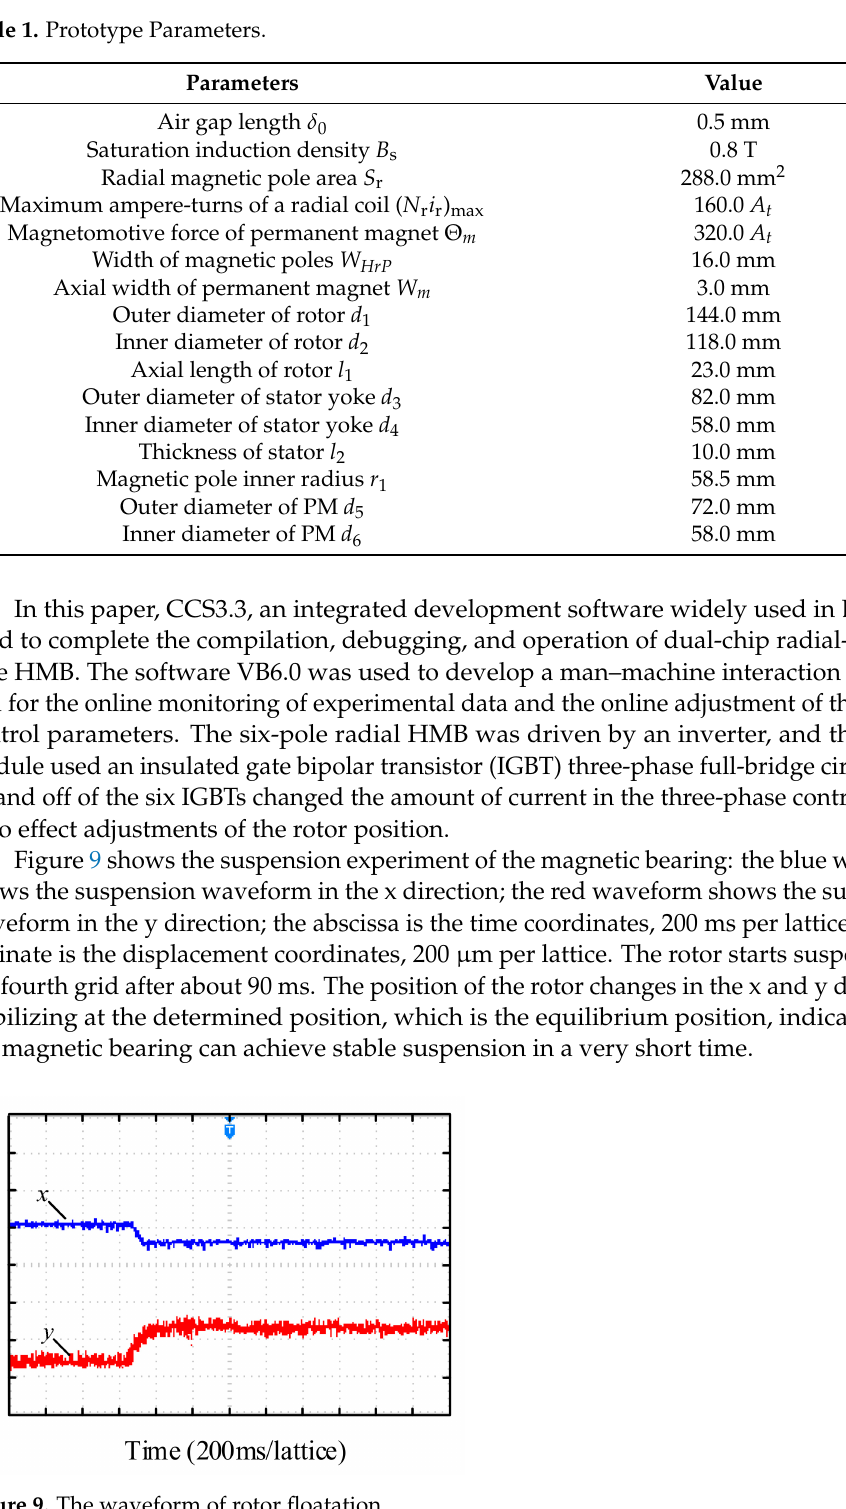
Figure 9. The waveform of rotor